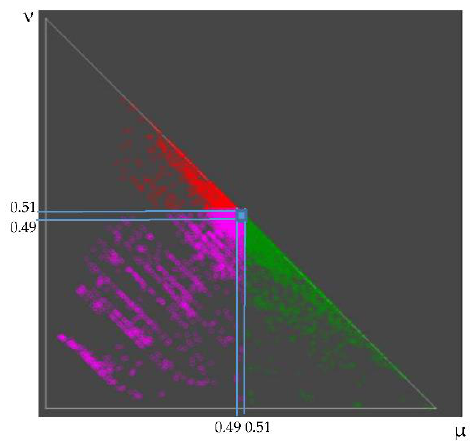
Figure 8. Ninety-eight criteria pairs that show almost equal values of degrees of agreement and disagreement—illustrated with the blue